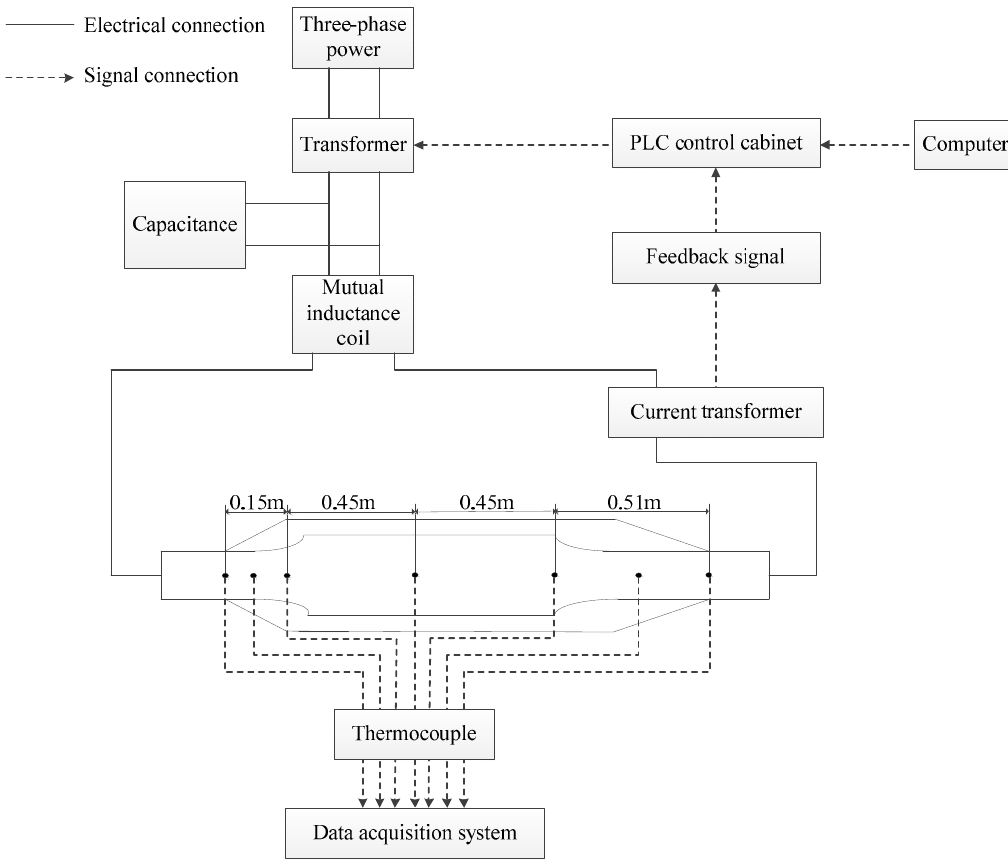
Figure 13. Schematic diagram of the experimental setup.